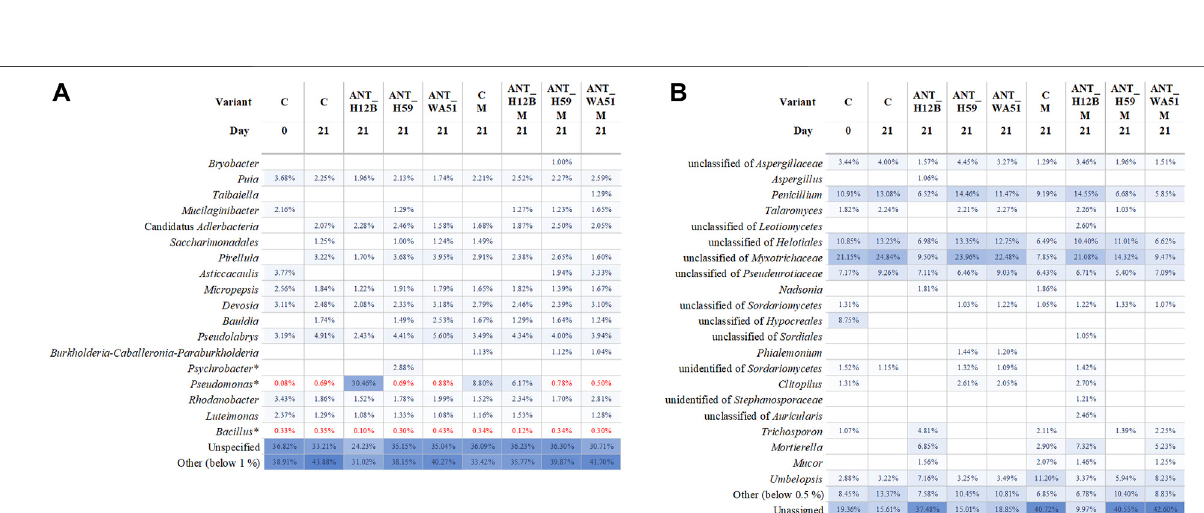
Frontiers in Bioengineering and Biotechnology |